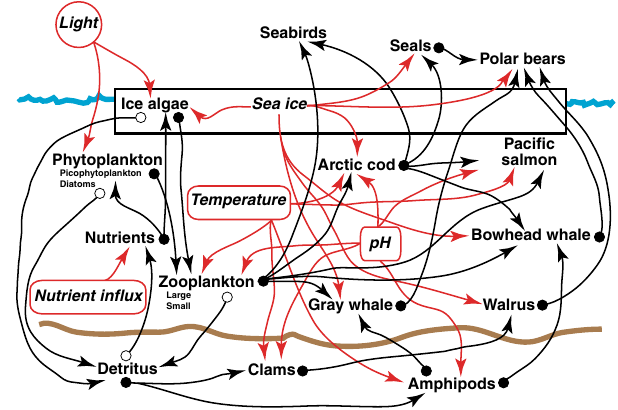
Fig. 1 Schematic of the modeled Arctic network model. Dynamic state variables or nodes (non-italicized labels) respond to changes in daily- de fi ned stressors (red arrows), changes in adjacent node values (black arrows), and the node-carrying capacity at each time step. Closed circles represent bidirectional connections; open circles represent unidirectional connections where the change in the target-node state does not affect the source-node state. Pairwise stressor interactions are possible among any two forcings that target the same node and are uniquely de fi ned for each node and stressor pairing. Node names represent the dominant species in a functional group (i.e., Arctic cod are the dominant small fi sh in the Chukchi Sea, although other small fi sh are also present). If no species is dominant within a functional group, then the name used is more generic (e.g., Clams). Shipping noise and strike stressors, as well as subsistence harvest of fi sh and marine mammals (Table 1), are not